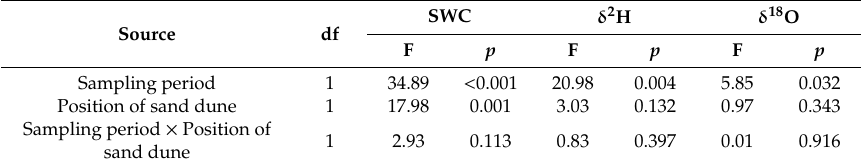
Figure 2. Vertical profiles (0–300 cm) of gravimetric soil water content (SWC) during the dry and wet periods at the top ( a ) and bottom ( b ) of sand dunes. Error bars represent standard deviation ( n = 4). Table 2. Summary results of mixed model analyses in gravimetric soil water content (SWC), xylem water δ 2 H and δ 18 O by sampling period, and position of sand dune.